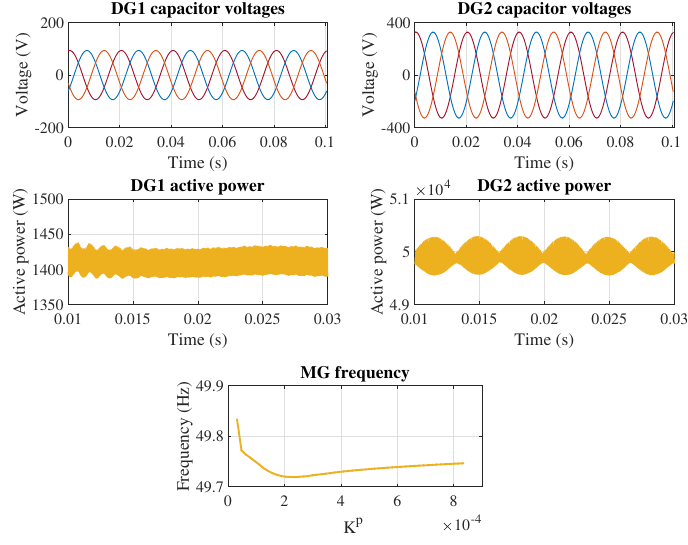
Figure A3. Time-domain simulation of five full-cycles of the computed unstable solution in Case 3, before the system collapses. Additionally, the system frequency during the whole K p